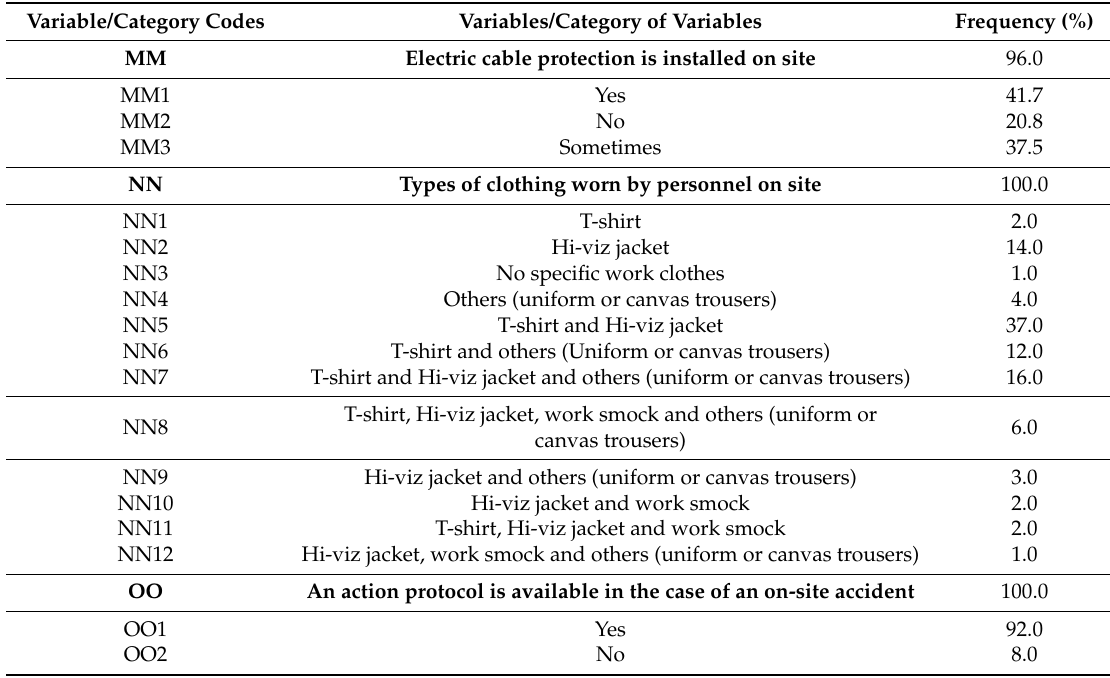
Table A5. Nomenclature and frequency of the categories of variables for Prevention Activities and Health and Safety Management in the company and on site (4th